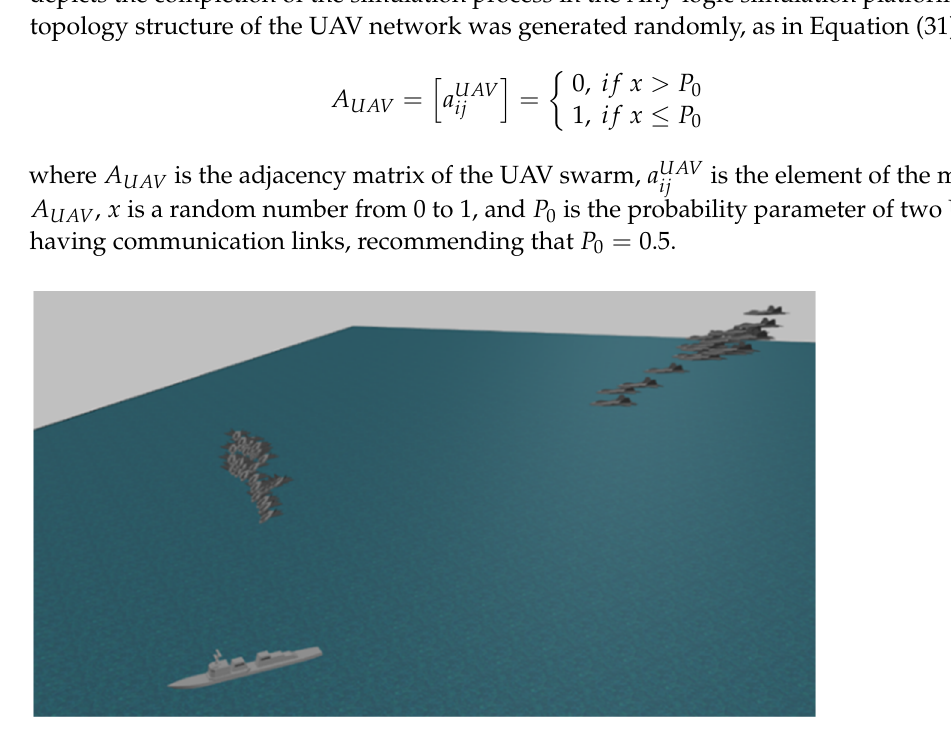
Table 4. Conditions of different scenarios.